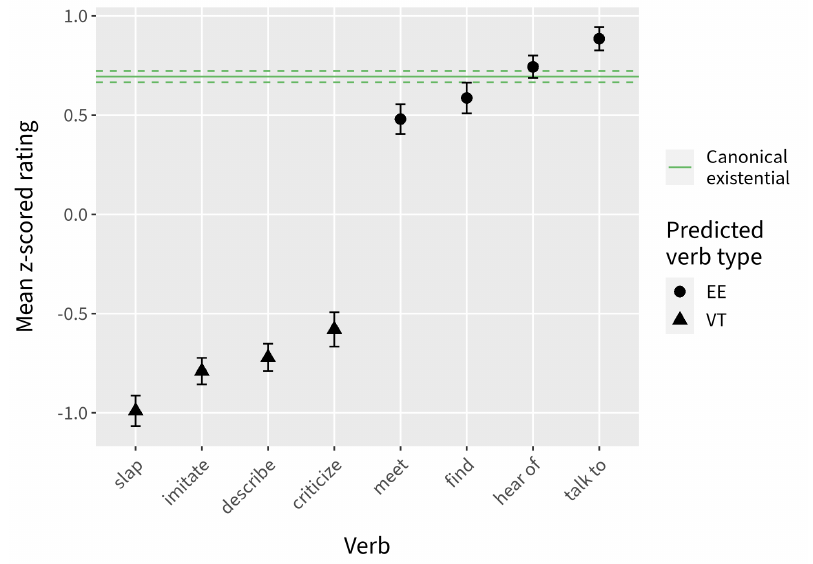
Figure 4. Mean z-scored ratings representing the felicitousness of making an existential claim with eight different matrix verbs (x-axis) in response to an existential question. Error bars (and dashed horizontal lines) represent the standard